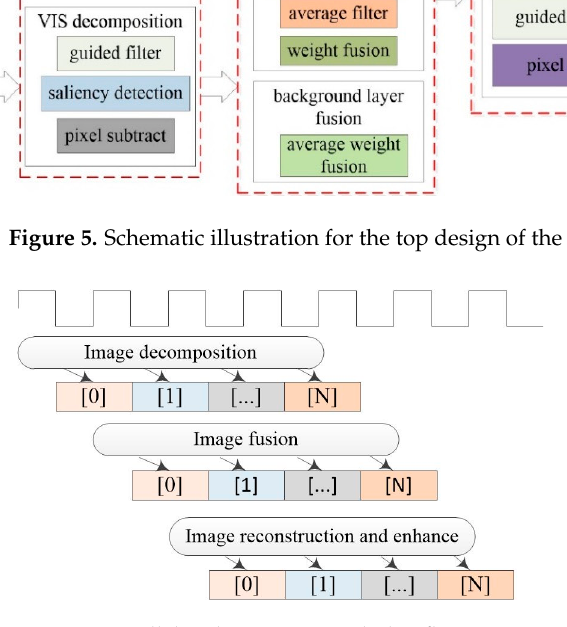
Figure 6. Parallelized operation with dataflow pragma.